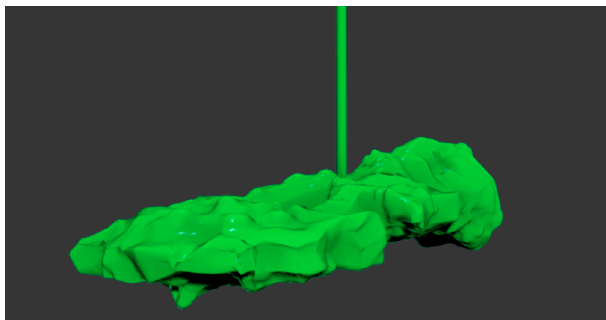
Figure 17. The three-dimensional model of the cave (h2).